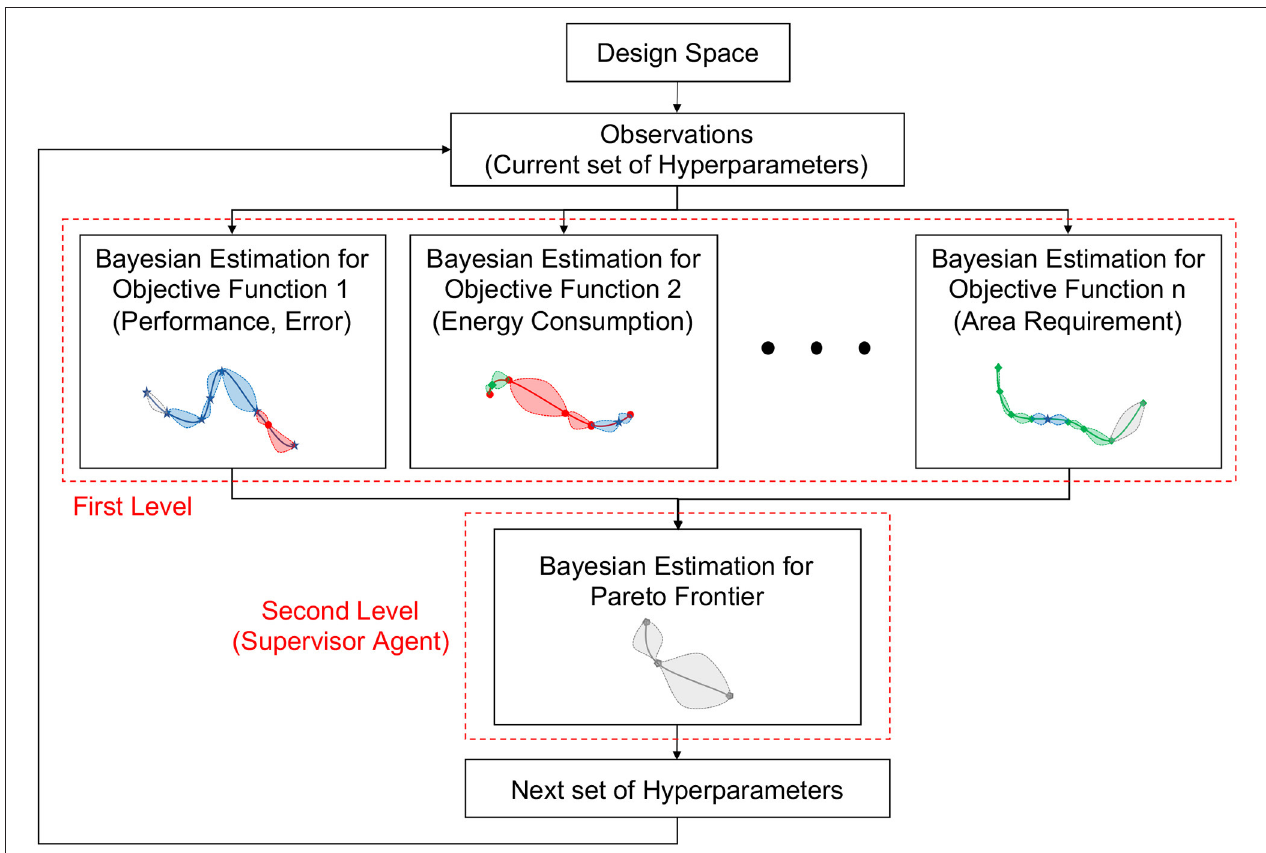
FIGURE 2 | Hierarchical-PABO